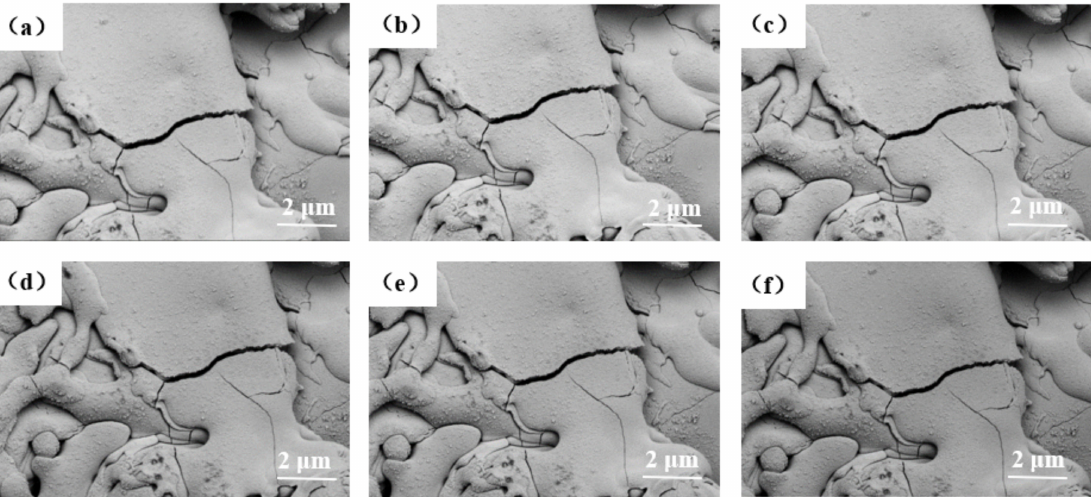
Figure 4. Locally enlarged view of a sample observed using in situ SEM at different temperatures without load: ( a ) 111 ◦ C; ( b ) 213 ◦ C; ( c ) 323 ◦ C; ( d ) 430 ◦ C; ( e ) 528 ◦ C; and ( f ) 766 ◦